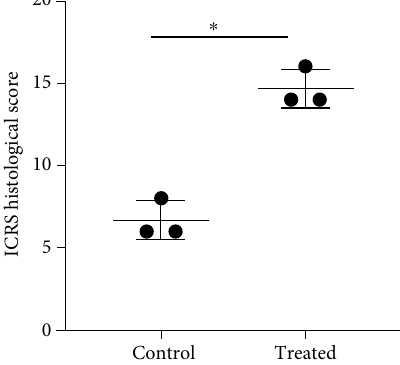
Figure 10: The International Cartilage Repair Society (ICRS) histological score for evaluating tissue regeneration in osteochondral defects in rabbit articular cartilage at 12 weeks posttreatment. The ICRS histological scores in the treatment group (iPSC – MSC-chondrocytes) were signi fi cantly higher than those in the control group ( n = 3 ). ∗ p = 0 : 02 . Statistical analyses between both groups were calculated with Mann – Whitney U